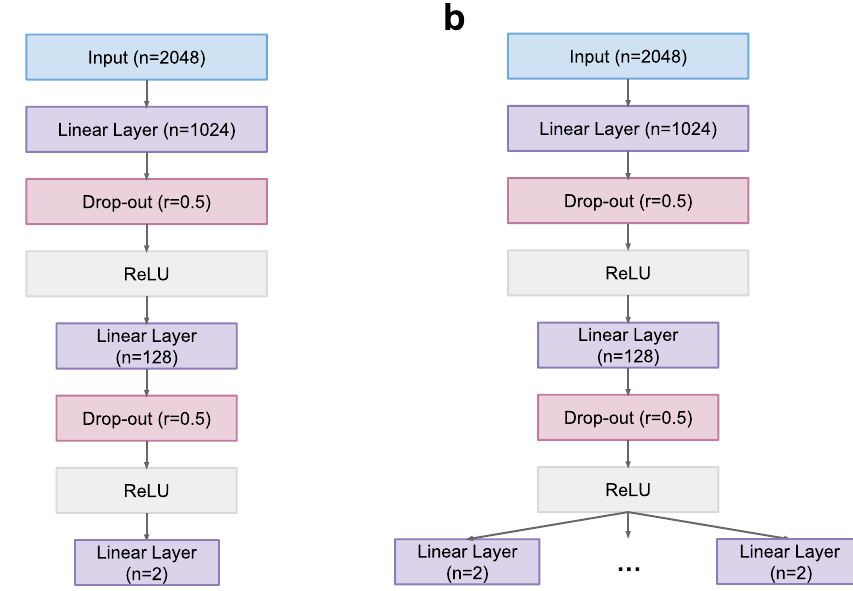
Figure 5. The architecture of models. ( a) Single-task learning model. ( b) Multi-task learning